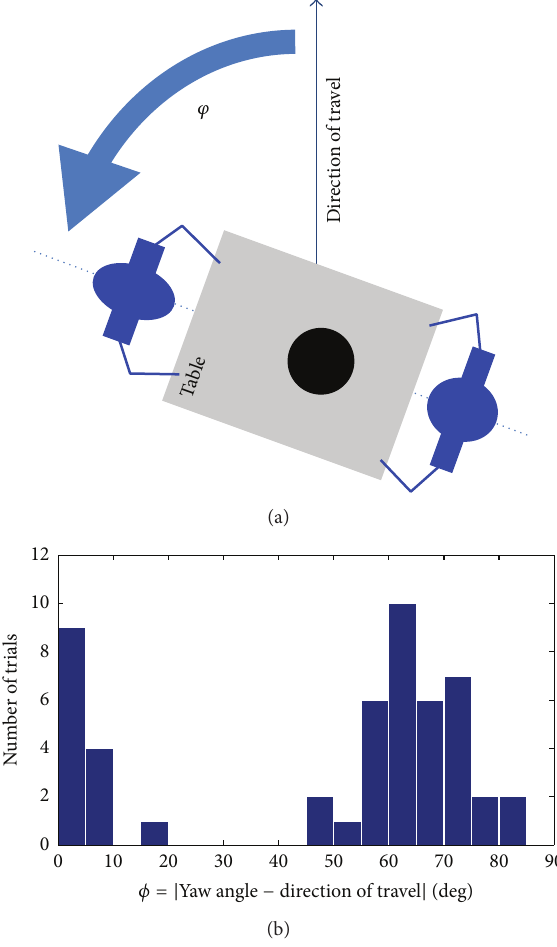
Figure3:(a)Illustrationoftheheadingdifferencebetweendirection of travel and table’s longitudinal axis (overhead view). (b) A histogram of the steady state mean heading difference in degrees for all trials which exhibited a near constant steady state